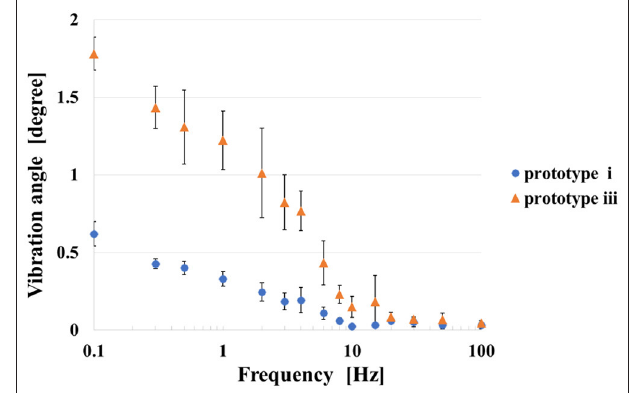
FIGURE 13 | Result of applying 5 kV AC voltage to prototype (i) and